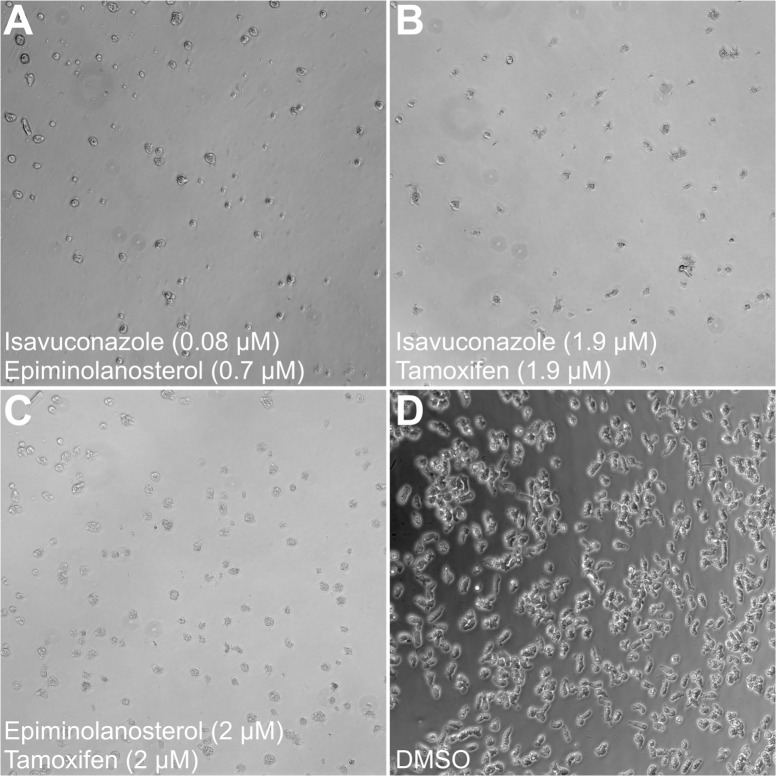
Synergistic effect of drugs at low concentrations.The phase contrast microscope images show N. fowleri trophozoites treated for 48 hours with (A) 0.08 μM of isavuconazole and 0.7 μM of epiminolanosterol, (B) 1.9 μM equimolar concentrations of isavuconazole and tamoxifen, (C) 2 μM equimolar concentrations of epiminolanosterol and tamoxifen, and (D) 0.5% DMSO, which served as a negative control. The inhibitor-treated N. fowleri cells visible in the microscope field are rounded, much smaller in size and not viable, whereas DMSO-treated cells are irregularly shaped with visible cytoplasm. Magnification, ×20.